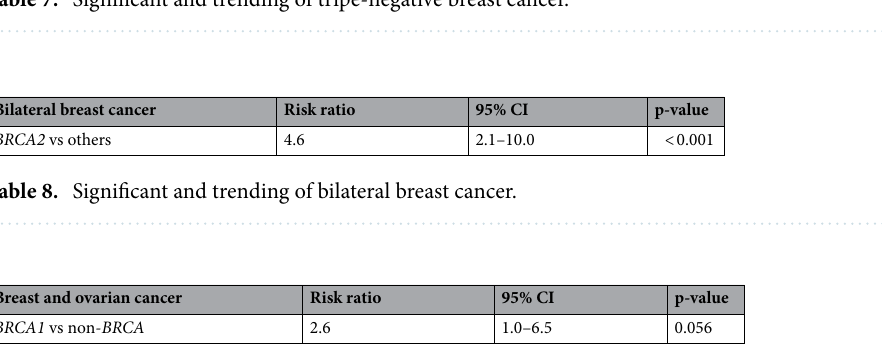
Table 7. Significant and trending of tripe-negative breast cancer.